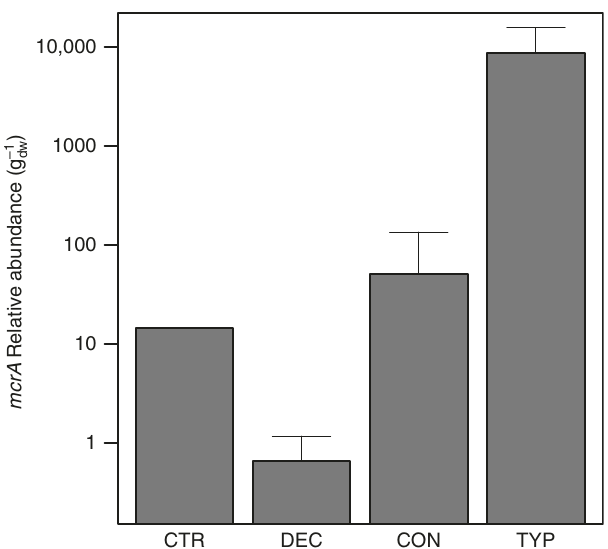
Fig. 2 Relative abundance of mcrA gene copies in amended sediments. Relative abundance is orders of magnitude higher in sediments amended with emergent macrophyte ( Typha latifolia ; TYP) litter than deciduous (DEC) or coniferous (CON) forest litter and mirrors CH 4 production in Fig. 1. DNA was pooled across replicates ( n = 4 per %OM treatment) and expressed as relative abundance per gram dry-weight (g dw ) of sediment normalized for extraction yield determined by qPCR. Samples were run in triplicate and compared to a standard curve generated from eDNA PCR product to capture the environmental variability in sequences. Error bars for amendments represent standard error across %OM treatments (10, 20, 40%)